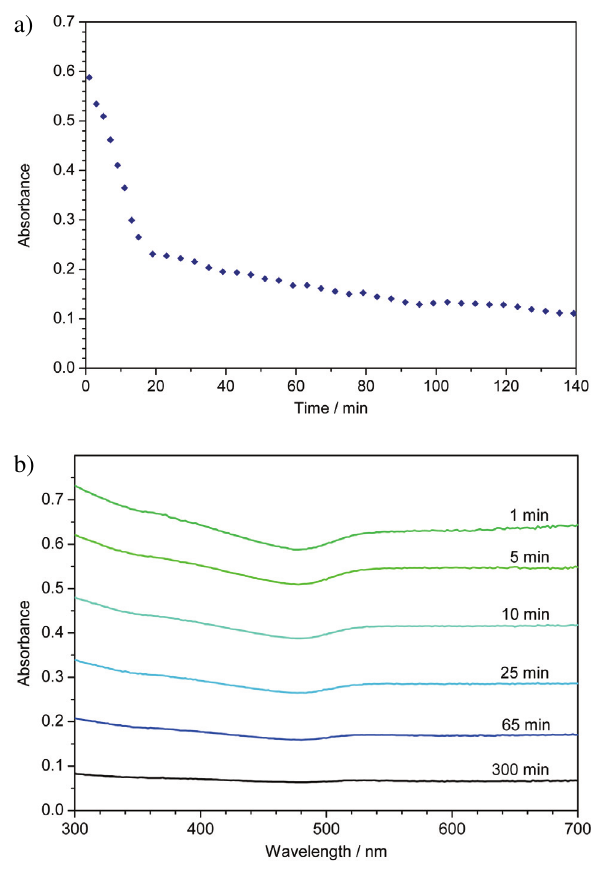
Figure 4. a) Absorbance of Au colloid (0.50 mM Au, 1 mL) at 480 nm as a function of time after the addition of HAuCl the NaBH /NaOH solution. b) Time-resolved UV-vis absorbance 4 spectra of the same